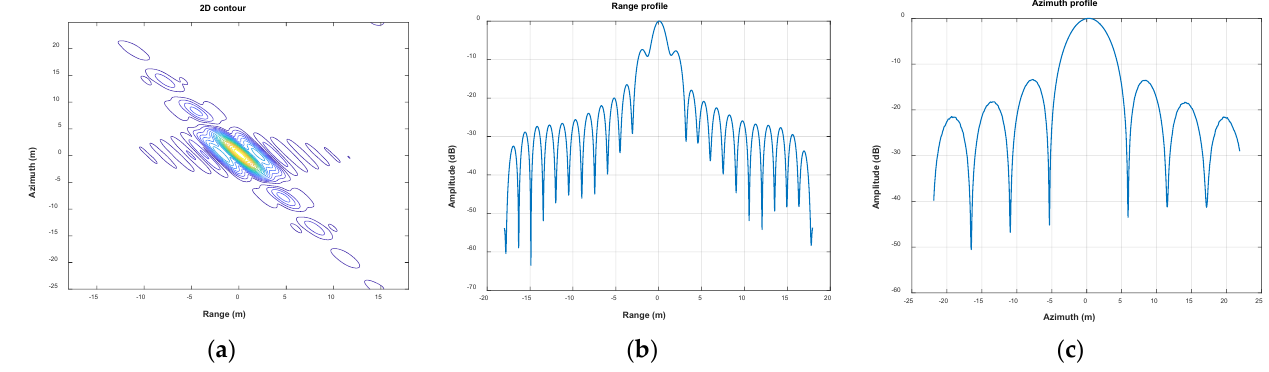
Figure 13. The 2D simulation results with the squint angle of 35 degrees. ( a ) is the 2D contour of the point target; ( b ) is the range profile and ( c ) is the azimuth profile.